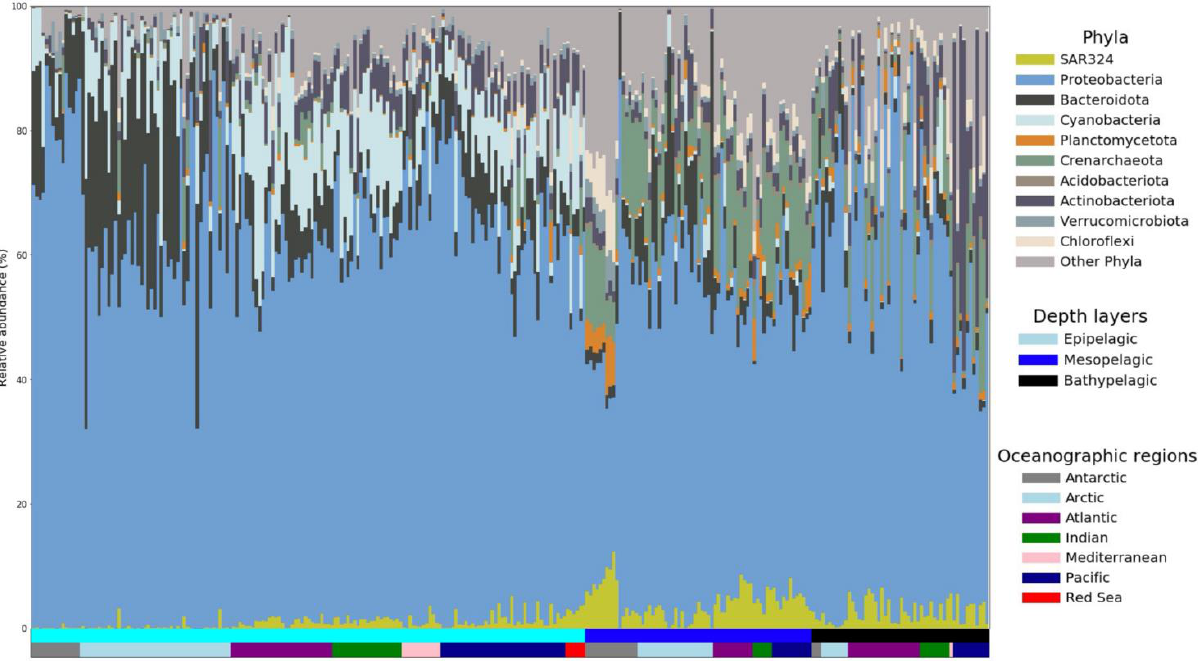
Figure 1. Relative sequence abundance of individual taxa of the microbial community in different oceanic basins based on annotated miTags. Each single bar on the x -axis represents a unique sample; they are ordered according to their depth layers from surface ( left side) to bathypelagic ( right side) and according to their geographic location within each depth layer.